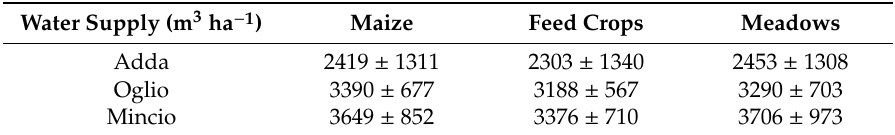
Table 4. Water supply to maize, feed crops, and meadows in the study area (Adda, Oglio, and Mincio watershed portion). Data source: